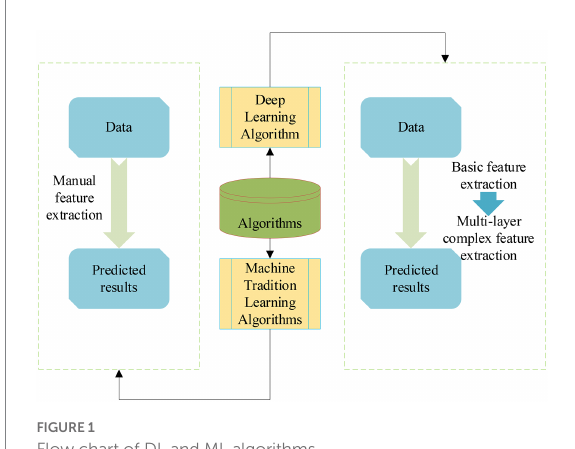
FIGURE 1 Flow chart of DL and ML algorithms.